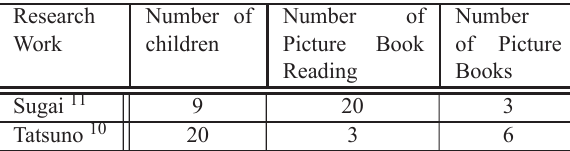
Table 1. Examples of Empirical Research